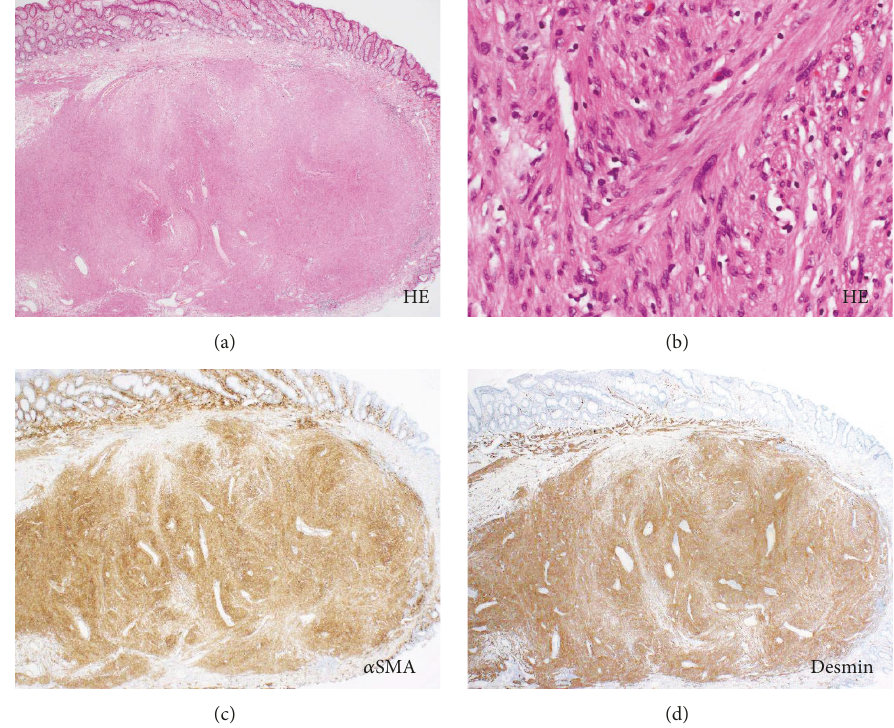
Figure 2: Pathological images of Case 1. A tumor composed of eosinophilic cells is observed. The tumor is covered with normal appearing mucosa ((a), hematoxylin and eosin staining, × 40). The tumor cells have relatively uniform nuclei, abundant cytoplasm, and indistinct cell boundaries. Mitoses are rarely observed ((b), hematoxylin and eosin staining, × 400). The cells are positive for 𝛼 -SMA ((c), × 40) and desmin ((d), ×